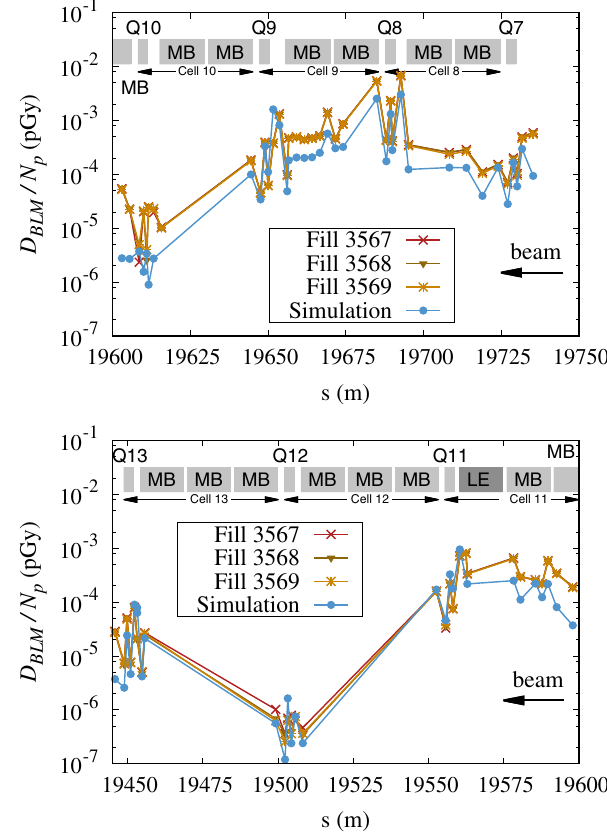
FIG. 10. Comparison of simulated and measured BLM signals in the dispersion suppressor (cells 8 – 11) and the first two arc half-cells (cells 12 and 13) next to the betatron cleaning insertion. The beam direction is from the right to the left. The measurements derive from the same fills as in Fig. 9. All signals are expressed per proton lost in the collimation system. The statistical error of simulation results is less than 10% for dose values above ∼ 10 − 4 pGy but can be as large as a factor of a few for dose values below ∼ 10 − 4